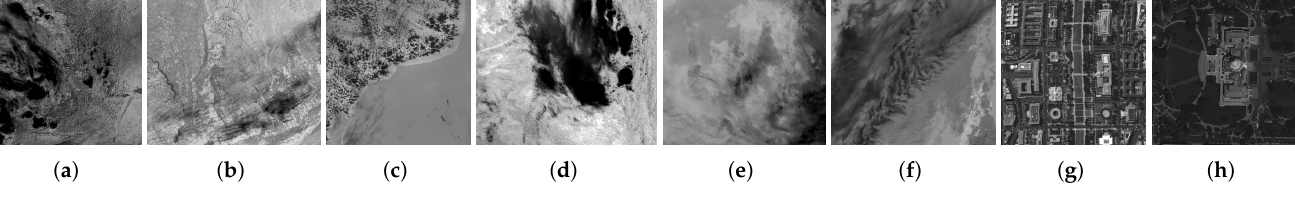
Figure 5. Test images. Images in ( a – h ) are from the Aqua MODIS dataset, Terra MODIS dataset, hyperspectral dataset, and multispectral dataset,